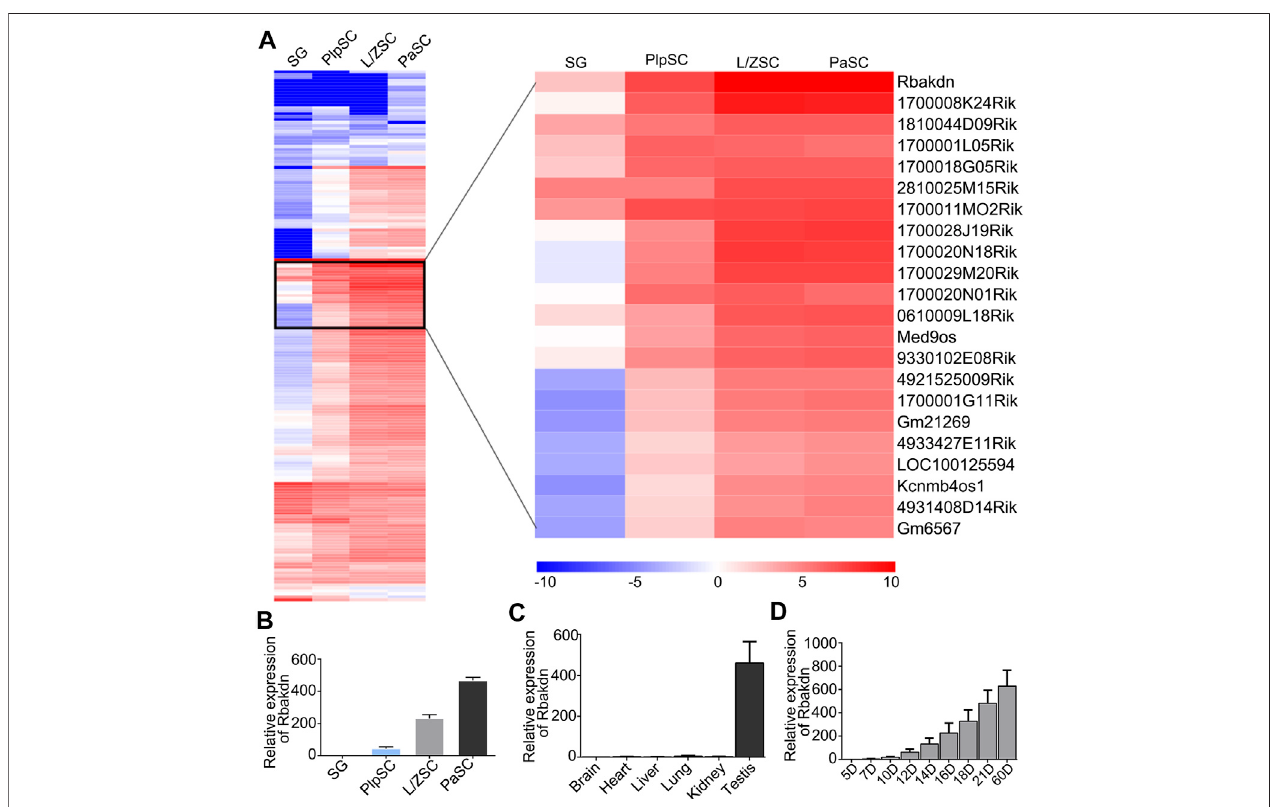
FIGURE 1 | The expression pattern of lncRNA Rbakdn in meiotic spermatogenic cells. (A) Heat map of long noncoding RNAs speci fi cally expressed in spermatogenic cells at different stages of meiosis. Blue represents low expression, and red represents high expression. The long noncoding RNA that is dynamically expressed and gradually increased during meiosis is enlarged on the right. Rbakdn is dynamically expressed and speci fi cally upregulated during meiosis. (B) Rbakdn expression at different stages of meiosis. (C) Rbakdn expression in brain, liver, heart, lung, kidney, and testis tissues from adult wild-type mice. (D) Rbakdn expression in testes from wild-type mice at different ages from 5 to 60 days after